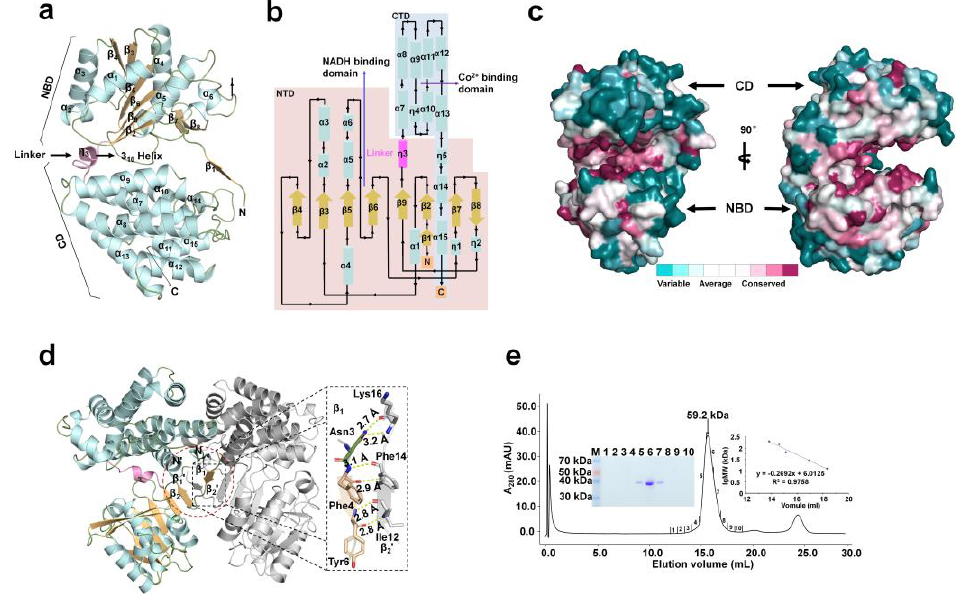
Figure 3. Crystal structure of FnYqdH. ( a ) Cartoon representation of monomer structure of FnYqdH consisting of the NBD, CD, and linker. ( b ) Topology diagram of FnYqdH. The α -helices (cyan) and β -strands (yellow) are indicated by rectangles and arrows, respectively. The smaller numbers indicate the beginning and ending residue number of each secondary structural element. The NTD is shadowed by light orange boxes. The CTD of FnYqdH is marked by a light cyan box. The linker is marked by a pink box. ( c ) Surface conservation of FnYqdH. The substrate-binding cleft between NBD and CD shows high conservation, whereas other regions are not conserved. ( d ) Dimer formation of FnYqdH. The hydrogen bonds between β1 and β2′ strands stabilize the dimeric interface of FnYqdH. ( e ) Profile of size-exclusion chromatography of FnYqdH revealed the dimer state in solution.